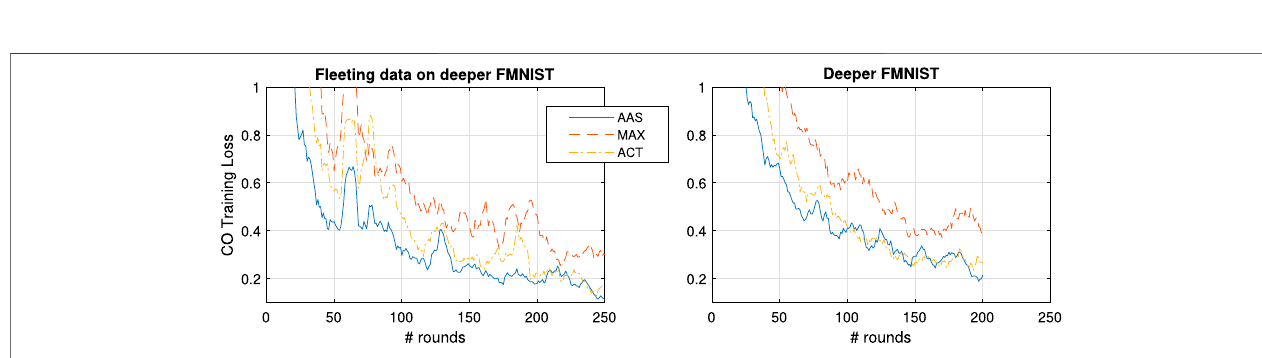
FIGURE 10 | 10-point moving average of CO training loss for μ (cid:2) 0 . 01 of the fl eeting data vs. normal data sampling in the deeper FMNIST testcase.